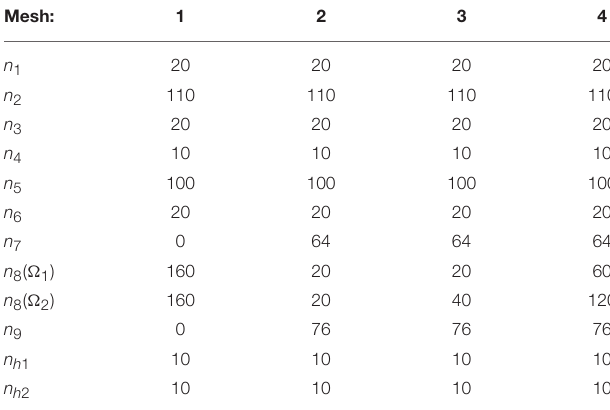
TABLE 4 | Values for the variables n i